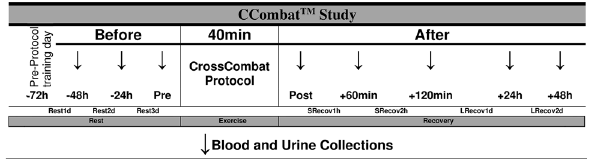
Figure 1. Experimental design. The subjects rested for 3 days before the CrossCombat (CCombat) protocol when samples were collected for 96 h, starting 2 days before (− 48 h; − 24 h) until 2 days after (24 h; 48 h) the exercise protocol (Pre; Post; + 60 min; + 120 min). The CCombat protocol started from 07:00 to 09:00, splitting the athletes to avoid overlapping the venipuncturist and securing immediate sample collections. Advanced-level CCombat training was performed for 40 min. Arrows indicate the eight-blood and urine collections